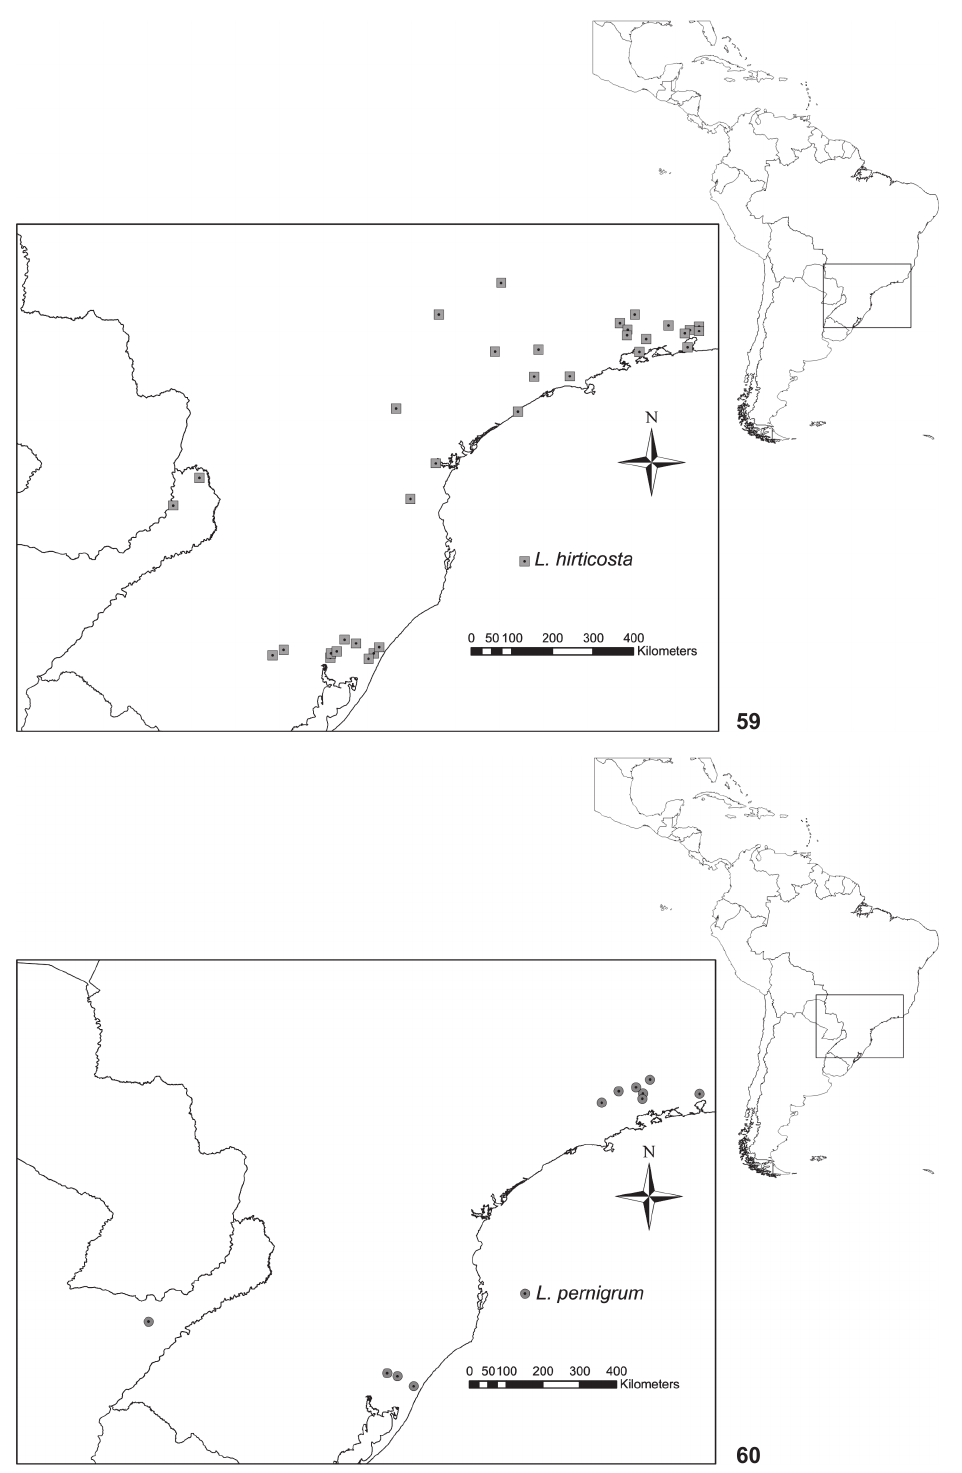
Figures 59-60. Distribution map of L. hirticosta (59) and L. pernigrum